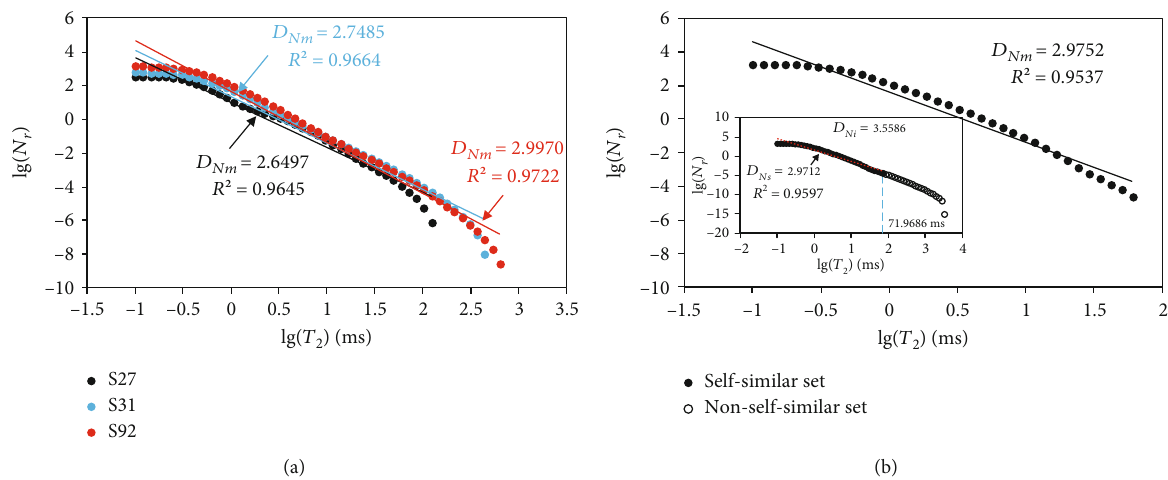
Þ and lg ð T Þ for (a) three typical samples and (b) 2 r : fractal dimension values of the self-similar set; D Ns